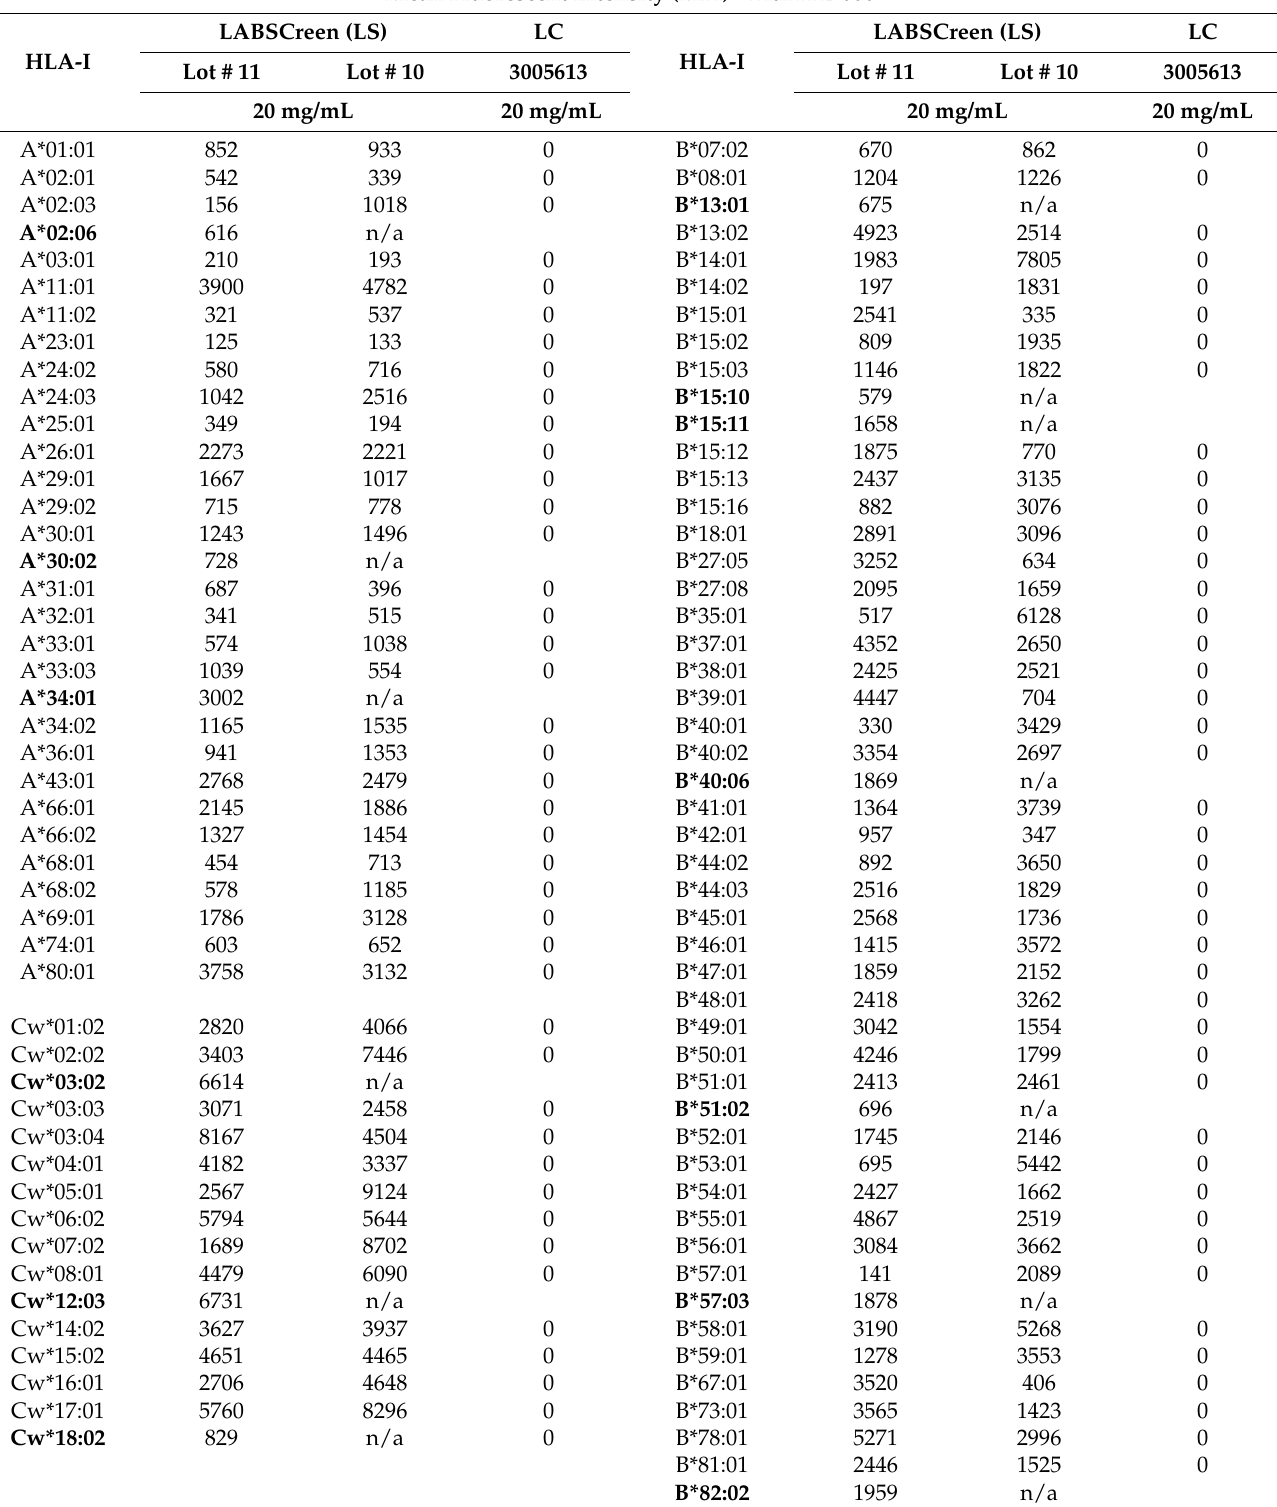
Table 7. Recognition pattern of the TFL-006 that binds to exposed cryptic epitopes found in β 2m-free HLA HCs